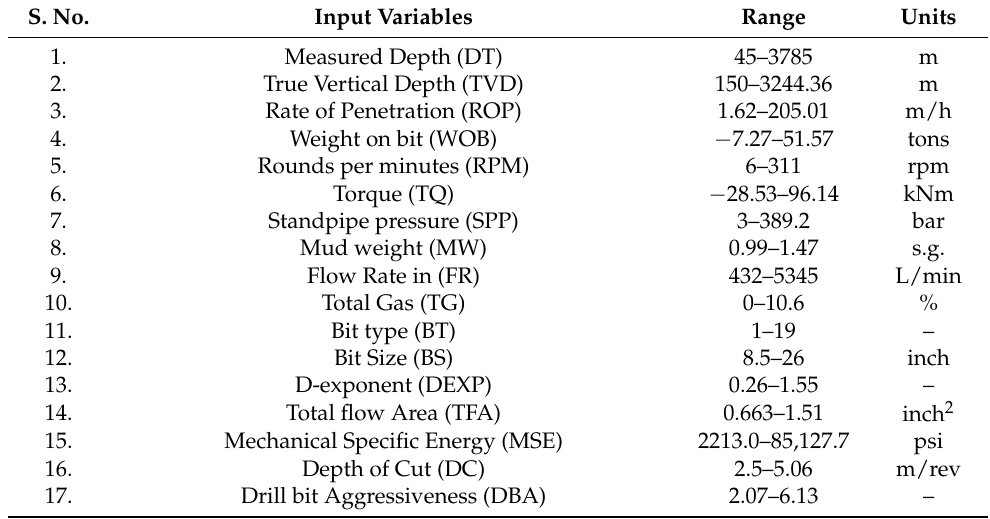
Table 3. Statistical details of collected drilling data of eight wells used in this